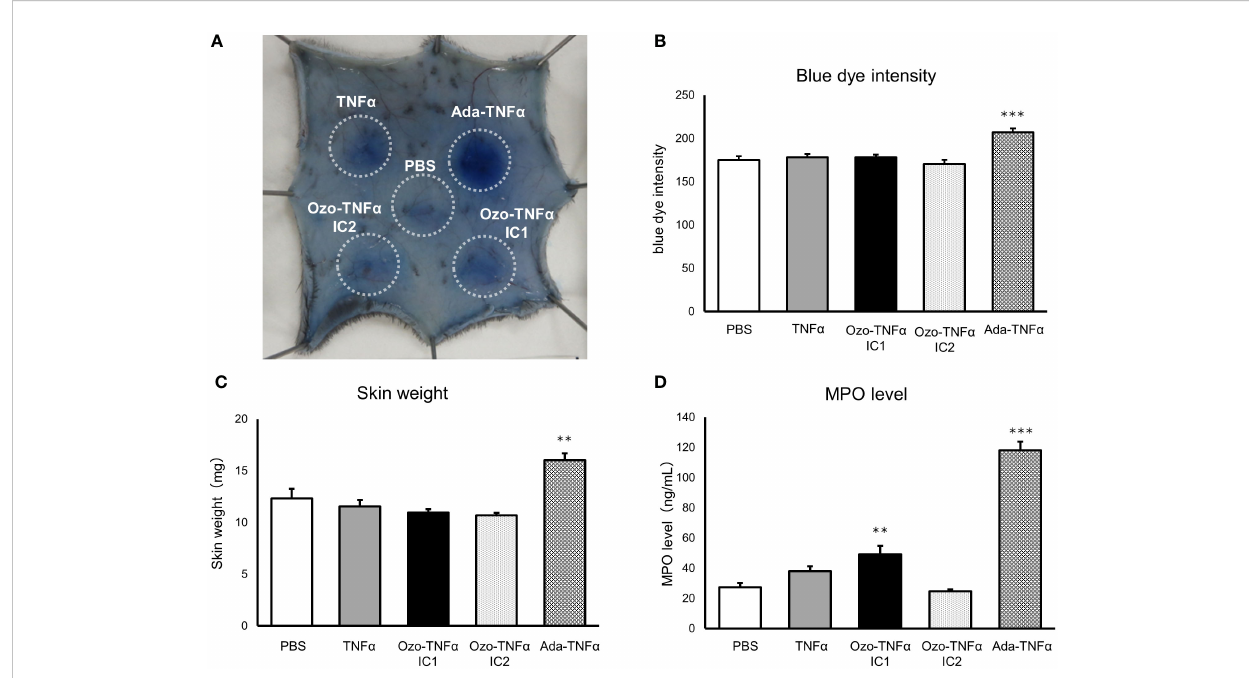
FIGURE 4 In fl ammatory responses in skin tissue injected with pre-incubated ICs. C57BL/6J mice were intradermally injected with PBS, TNF a , ozoralizumab- TNF a IC1 (Ozo-TNF a IC1), ozoralizumab-TNF a IC2 (Ozo-TNF a IC2), or adalimumab-TNF a ICs (Ada-TNF a ICs). Degree of plasma exudation was evaluated by monitoring after intravenous injection of 0.5% Evans blue. (A) Representative macroscopic appearance of the subcutaneous in fl ammation. The circles surround the exuded Evans blue dye at each injection site. (B) Blue dye intensity quanti fi ed with ImageJ software. (C) Weight of 6-mm skin punch biopsy specimens. (D) MPO levels in tissue supernatant extracted from the 6-mm skin punch biopsy specimens. Data are expressed as mean ± SE. n = 7-8 ∗∗ p <0.01, ∗∗∗ p <0.001 vs. PBS (Tukey ’ s